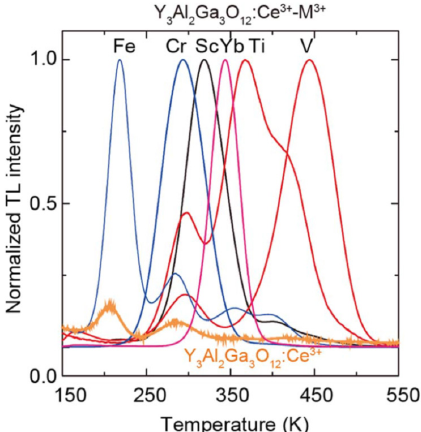
Figure 11. Schematic of the band structure of undoped LuAG (left) with the antisite defect in the band gap 0.29 eV below the conduction band, compared to the band shift due to Ga admix, where the defect level is no longer in the forbidden gap (From